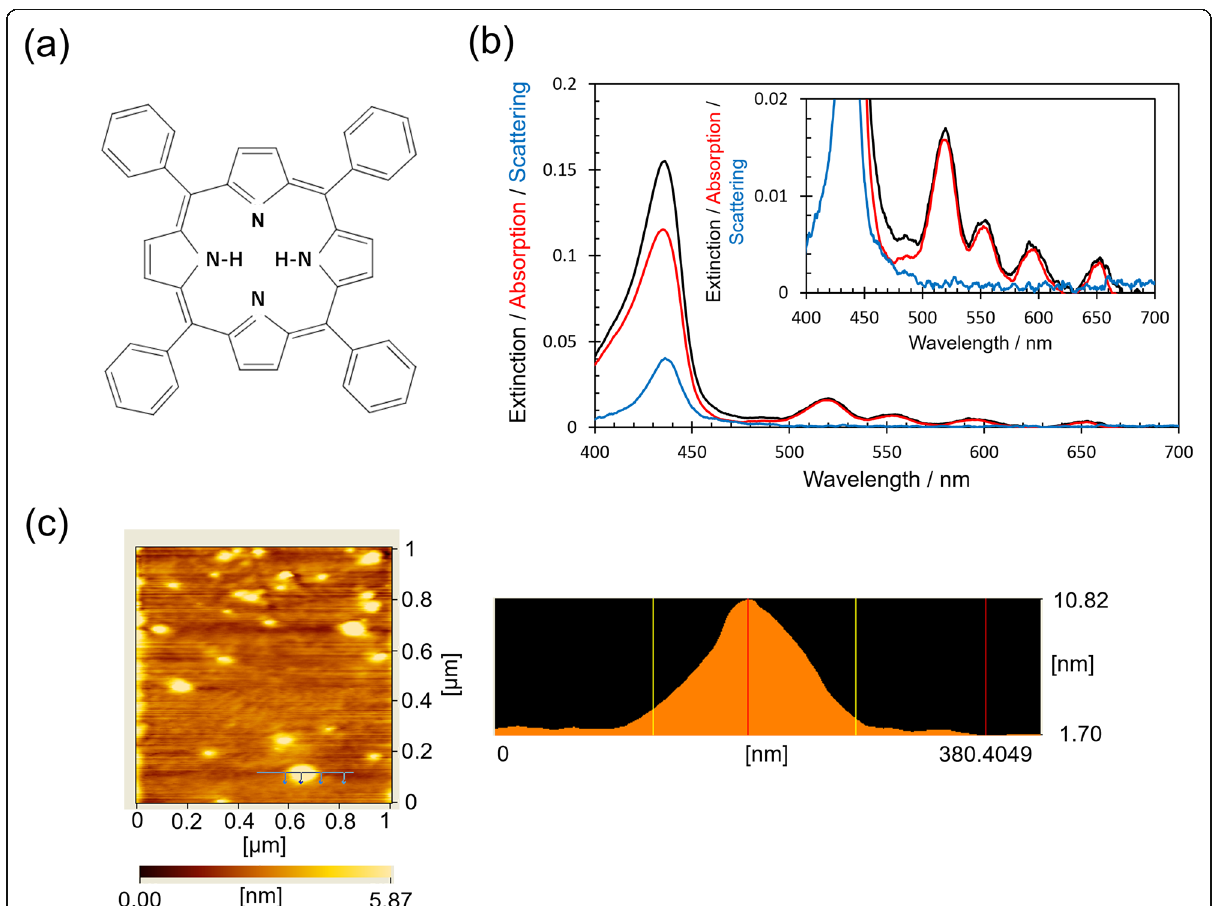
Fig. 1 a Molecular structure of TPP. b Extinction (black line), absorption (red line), and scattering (blue line) spectra of TPP/glass. Inset shows magnification of Q-bands. c AFM image of the surface of